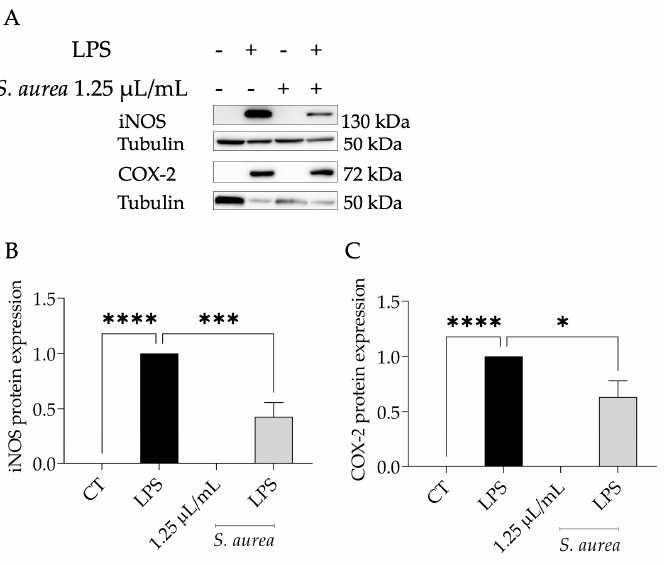
Figure 2. Effect of S. aurea EO on iNOS and COX-2 levels. ( A ) Shows representative blots. The positive (+) and negative (-) signals represent the presence or absence of the condition in the row. ( B ) Focuses on the semi-quantitative analysis of iNOS protein levels. Panel ( C ) focuses on the semi-quantitative analysis of COX-2 protein levels. Tubulin content was used to normalize the protein levels of iNOS and COX-2. Results show the mean +/- SEM. Statistical significance (* p < 0.05, *** p < 0.001,